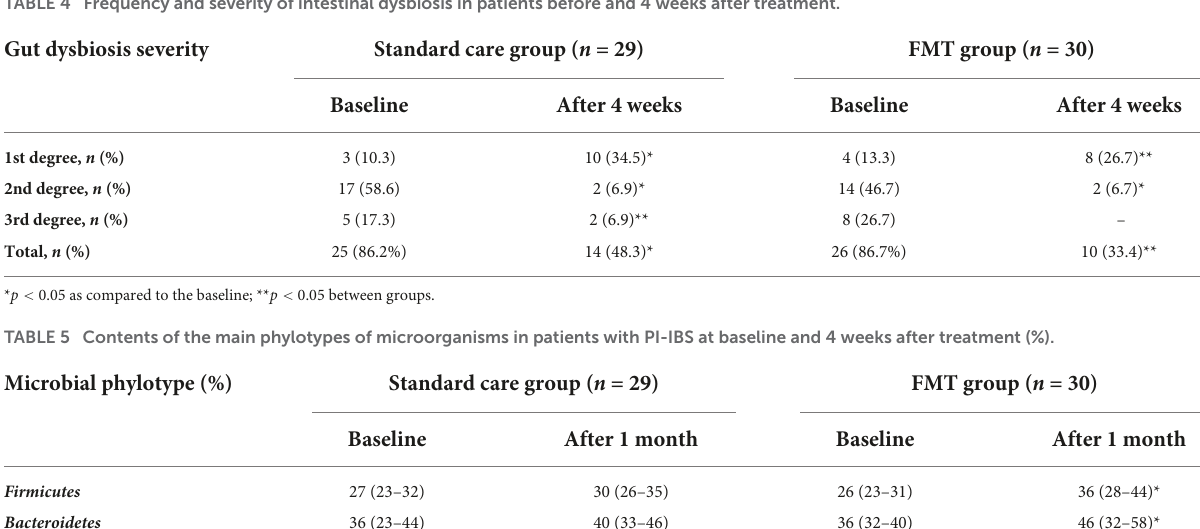
TABLE 4 Frequency and severity of intestinal dysbiosis in patients before and 4 weeks after treatment.